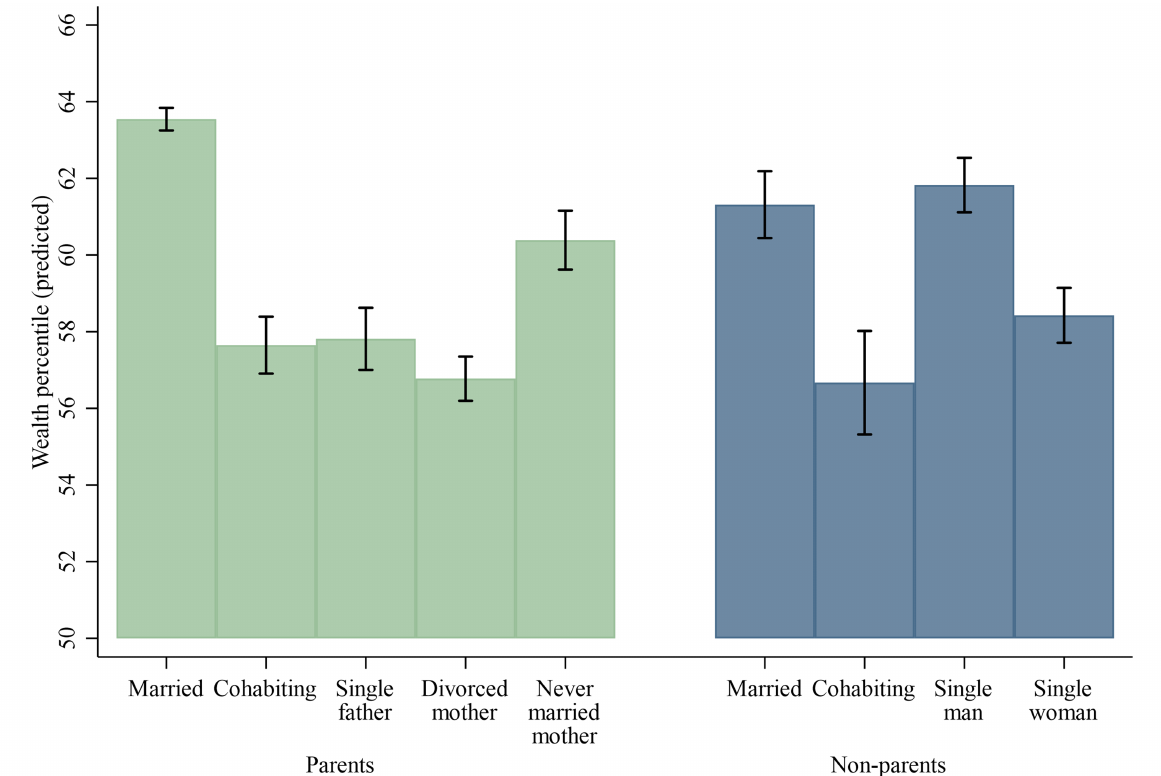
Figure 1: Predicted net worth percentiles, by household type. Notes: Error bars represent 95 percent confidence intervals. Estimates are adjusted for demographic and income variables and year fixed effects. N = 41,